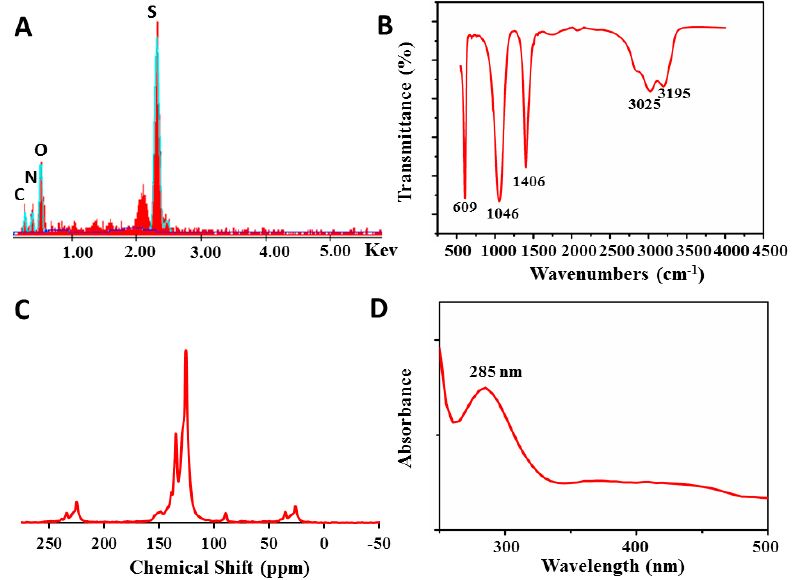
Figure 3. ( A ) energy-dispersive X-ray (EDX), ( B ) Fourier-transform infrared (FTIR), ( C ) 13 C solid-state NMR, and ( D ) ultraviolet–visible (UV–Vis) spectra of sulfonated polyaniline (PANI).